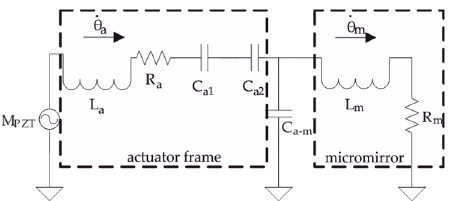
Figure 3. Equivalent electric circuit describing mechanical behavior of micromirrors and actuators. Table 1. The electric components and the equivalent mechanical parameters.